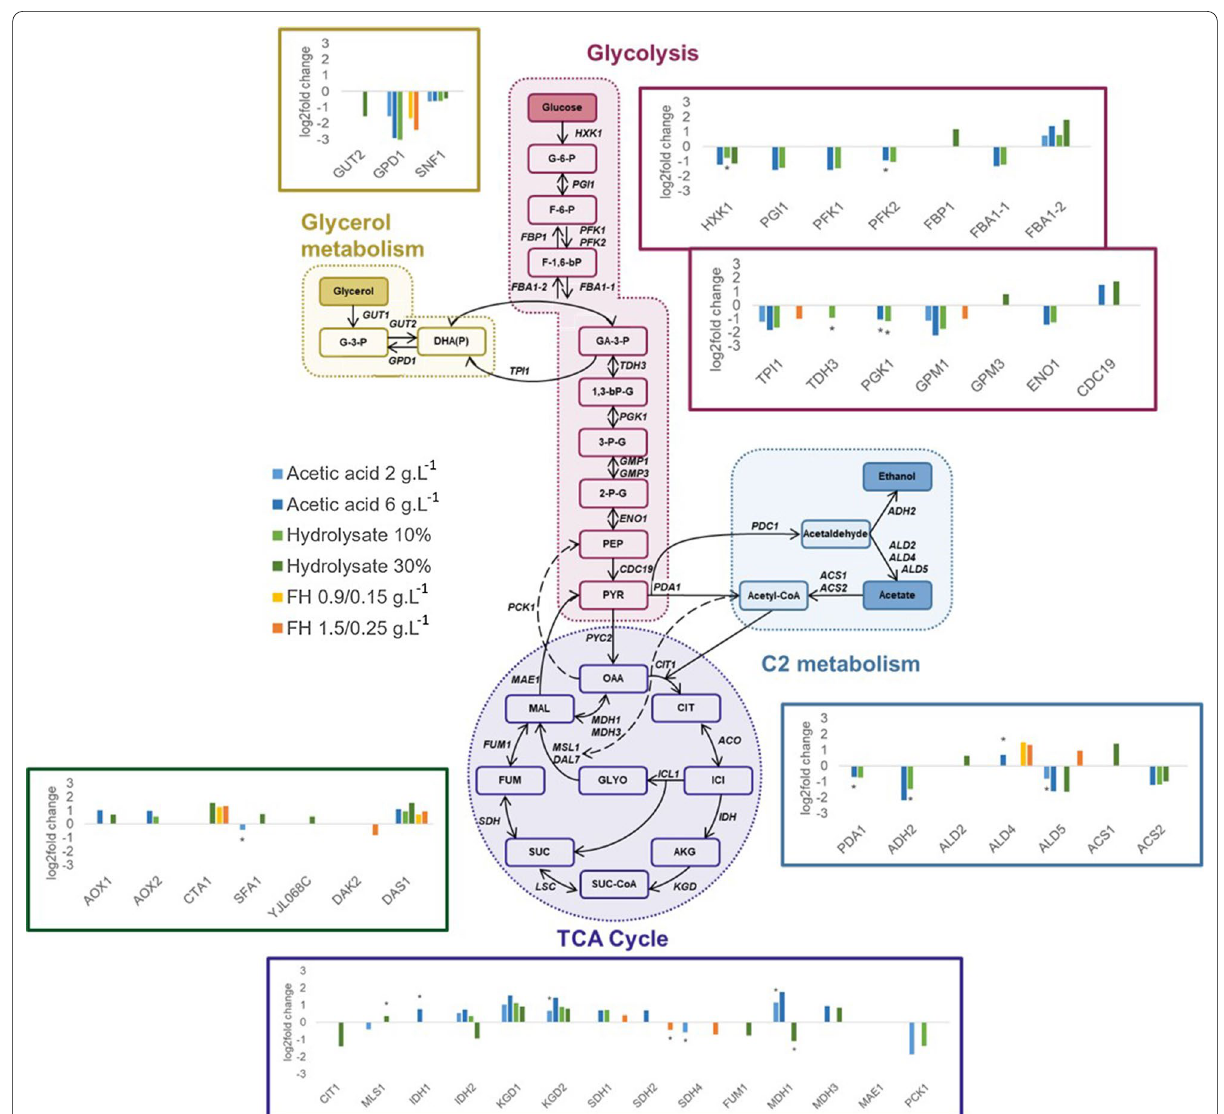
Fig. 4 Gene expression of central carbon metabolism pathways for P. pastoris . Possible carbon sources are presented in colored squares: glucose; glycerol, ethanol, acetate. Bar charts represent the transcriptional changes (log2 fold) of genes in acetic acid 2 g.L − 1 (light blue), 6 g. L − 1 (dark blue), FH 0.9/0.15 g.L − 1 (yellow), FH 1.5/0.25 g.L − 1 (orange), hydrolysate 10% (light green) and 30% (dark green) with P -values < 0.05 or 0.1 (*on top of bar chart). Metabolites: G-6-P glucose 6-phosphate, F-6-P fructose-6-phosphate, F-1,6-P fructose 1,6-phosphate, G-3-P glycerol 3-phosphate, GA-3-P glyceraldehyde 3-phopshate, 1,3-bPG 1,3-bisphosphoglycerate, 3-PG 3-phosphoglycerate, 2-PG 2-phosphoglycerate, PEP phosphoenolpyruvate, PYR pyruvate, DHA(P) dihydroxy acetone (phosphate), OAA oxaloacetate, CIT citrate, ICI isocitrate, AKG alpha-keto glutarate, SUC succinate, SUC-CoA succinyl-Coenzyme A, FUM fumarate, MAL malate, GLYO glyoxylate. Enzymes: HXK1 hexokinase, PGI1 phosphoglucose isomerase, PFK1/2 phosphofructokinase, FBP1 fructose-1,6-bisphosphatase, FBA1-1/1-2 fructose 1,6-bisphosphate aldolase, TPI1 triose phosphate isomerase, TDH3 glyceraldehyde-3-phosphate dehydrogenase, PGK1 3-phosphoglycerate kinase, GPM1/3 phosphoglycerate mutase, ENO1 enolase I, phosphopyruvate hydratase, CDC19 pyruvate kinase, GUT1 glycerolkinase, GUT2 glycerol-3-phosphate dehydrogenase, GPD1 glycerol-3-phosphate dehydrogenase, SNF1 central kinase, PYC2 pyruvate carboxylase, CIT1 citrate synthase, ACO1/2 aconitase, ICL1 isocitrate lyase, DAL7 malate synthase, IDH1/2 isocitrate dehydrogenase, KGD1 alpha-ketoglutarate dehydrogenase complex, KGD2 dihydrolipoyl transsuccinylase, LSC1 succinyl-CoA ligase, SDH1/2/4 succinate dehydrogenase, FUM1 fumarase, MDH1 mitochondrial malate dehydrogenase, MDH3 malate dehydrogenase, MAE1 mitochondrial malic enzyme, PDC1 pyruvate decarboxylase, PDA1 pyruvate dehydrogenase (subunit from PDH complex), ALD2 cytoplasmic aldehyde dehydrogenase, ALD4-1/4-2/5 mitochondrial aldehyde dehydrogenase, ADH2 alcohol dehydrogenase, ACS1/2 acetyl-coA synthetase, PCK1 phosphoenolpyruvate carboxykinase. Genes or conditions with P -values out of the threshold were not